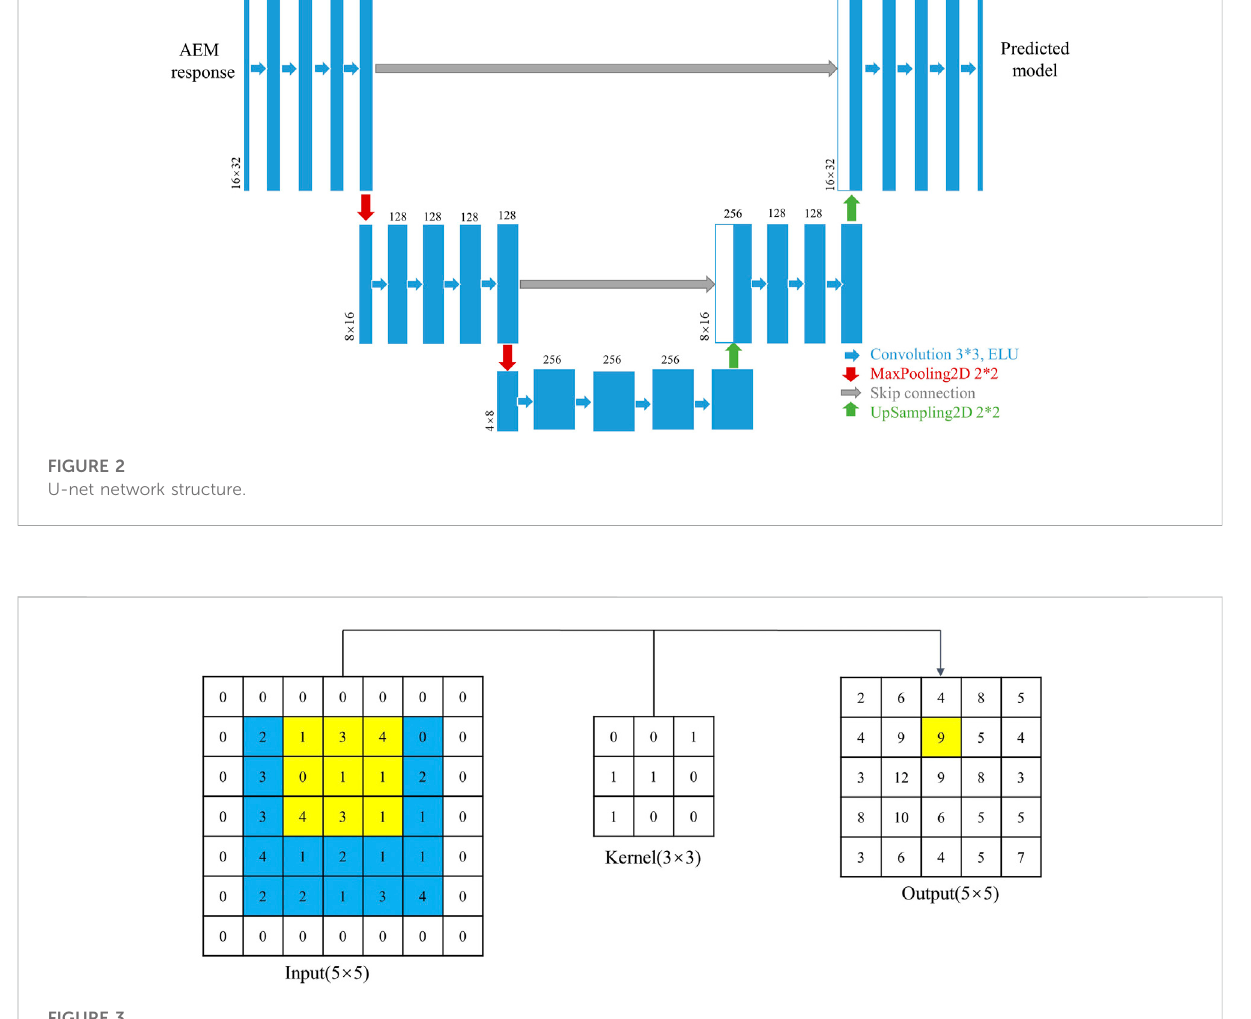
different complexities. The simple training set contains 50,000 samples, while the complex training set contains 100,000 samples. The model sizes of the two training sets are the same, both have 16 × 32 grids, but the simple training set has uniform background and contains only one abnormal body. For the complex training set, we divide the background into upper and lower layers, with the layer interface being randomly set. In addition, we put up to three (0 – 3) abnormal bodies randomly in the layered background. As for the resistivities, we assign the background resistivity randomly within 1 Ω · m — 10,000 Ω · m (logarithmically 0 – 9.21) and the abnormal resistivities